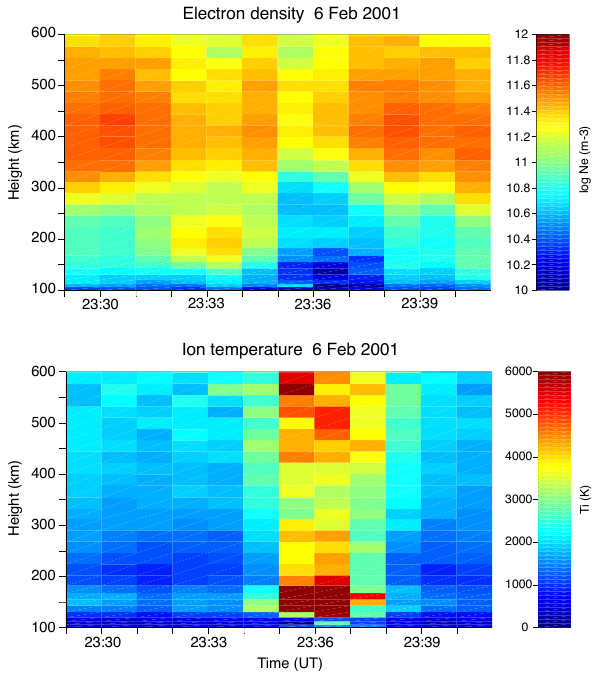
Fig. 11. Electron fluxes together with FACs and electric fluctuations measured by C2. From top to bottom: high-resolution electric field from the EFW, FAC (positive values correspond to current away from the ionosphere) from the FGM, and electron fluxes in the anti- parallel, perpendicular and parallel to B directions from the PEACE HEEA instrument in units of erg cm − 2 str − 1 s − 1 eV − 1 (calibration version